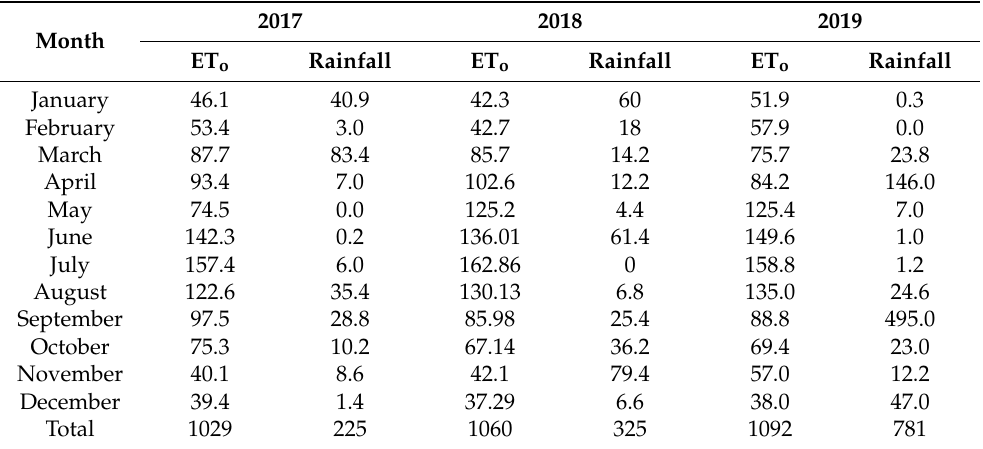
Table 2. Reference evapotranspiration (ET o ) and rainfall during the three experimental seasons. Data reported are monthly and annual cumulative values in mm.